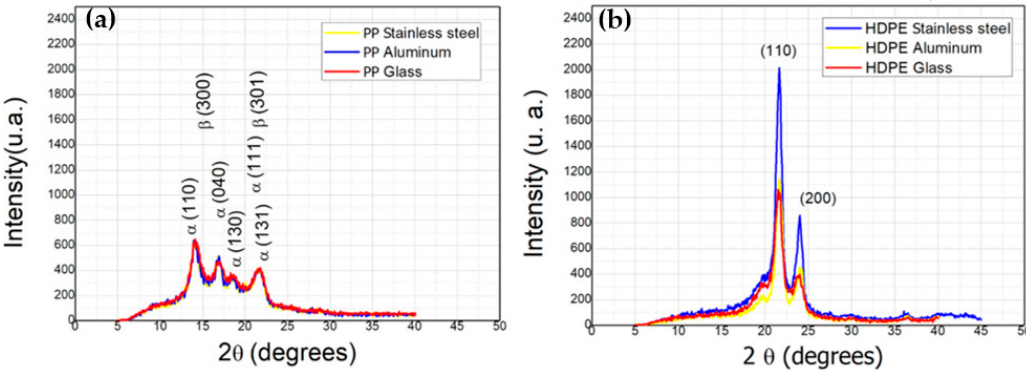
Figure 5. Diffractograms: ( a ) PP rotomolded material processed with stainless steel, aluminum, and glass mold; ( b ) HDPE rotomolded material processed with stainless steel, aluminum, and glass mold.